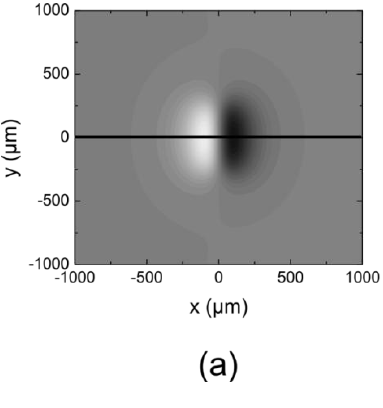
and Δ x characterize the signal. z ,max max is z